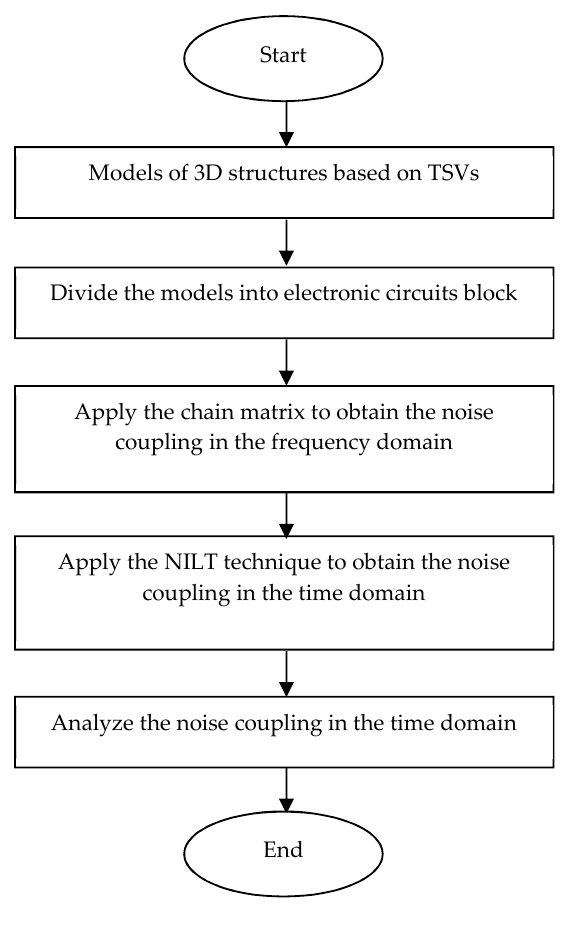
Figure 8. Block diagram of the proposed method.